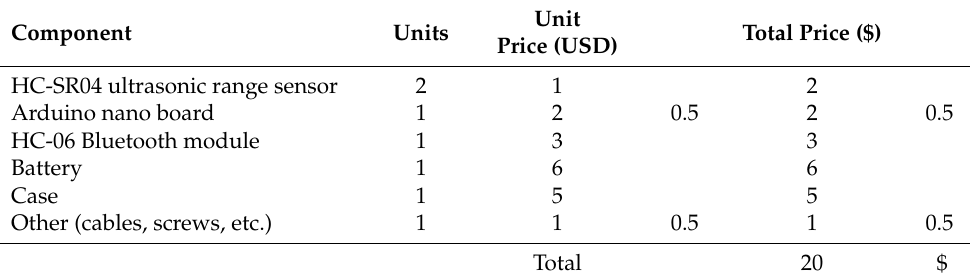
Table 3. Estimated cost of the eBAT based on components’